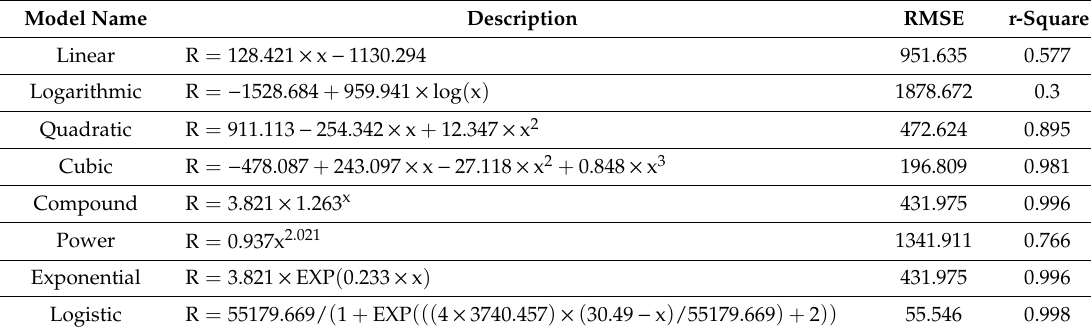
Table 14. Model description for Germany fitted by